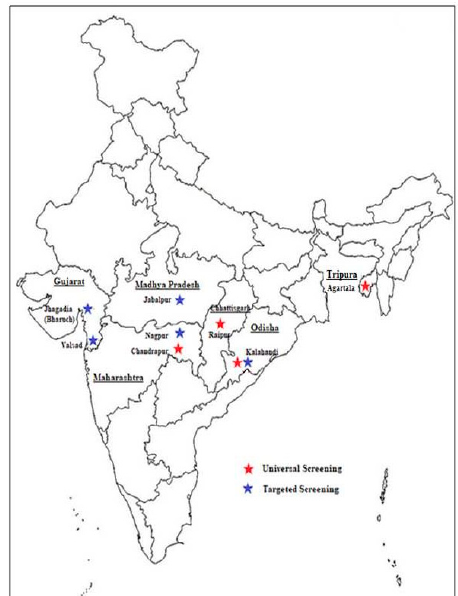
Figure 1. Location of the different centers in India where newborn screening was undertaken.